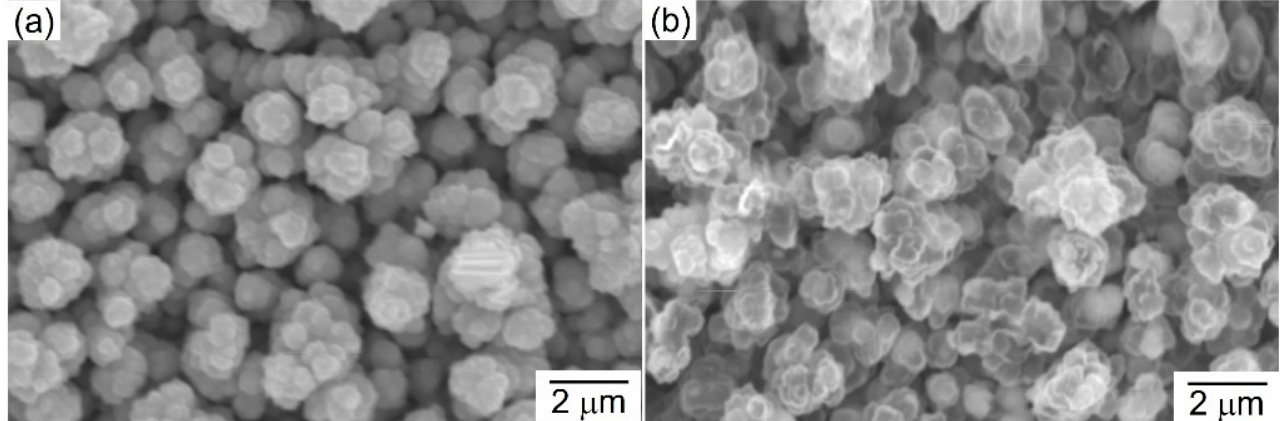
Figure 3. SEM images of ZnTe thin films with as-deposition ( a ) and annealing at 683 K for 5 h ( b ). The sample was electrodeposited at the cathode potential of − 0.8 V.